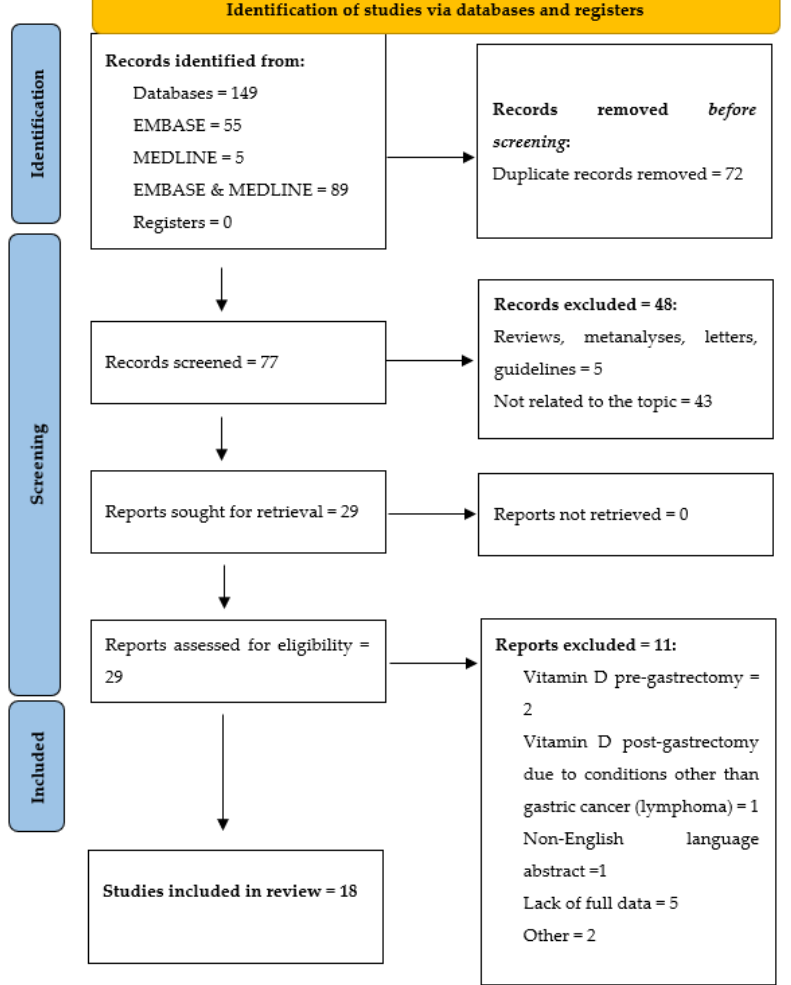
Figure 1. Identification of studies via databases and registers according to the PRISMA guidelines.